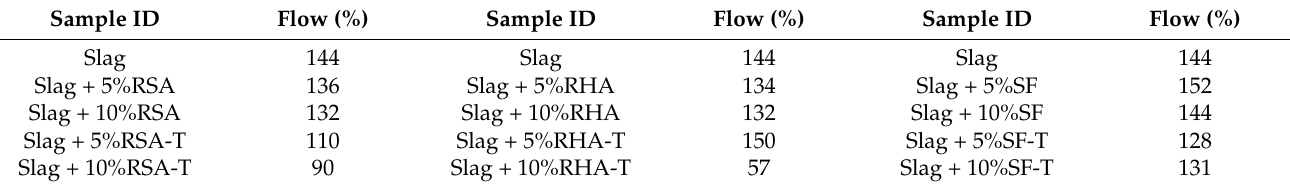
Table 3. Flow of alkali activated slag mortars prepared with 4M